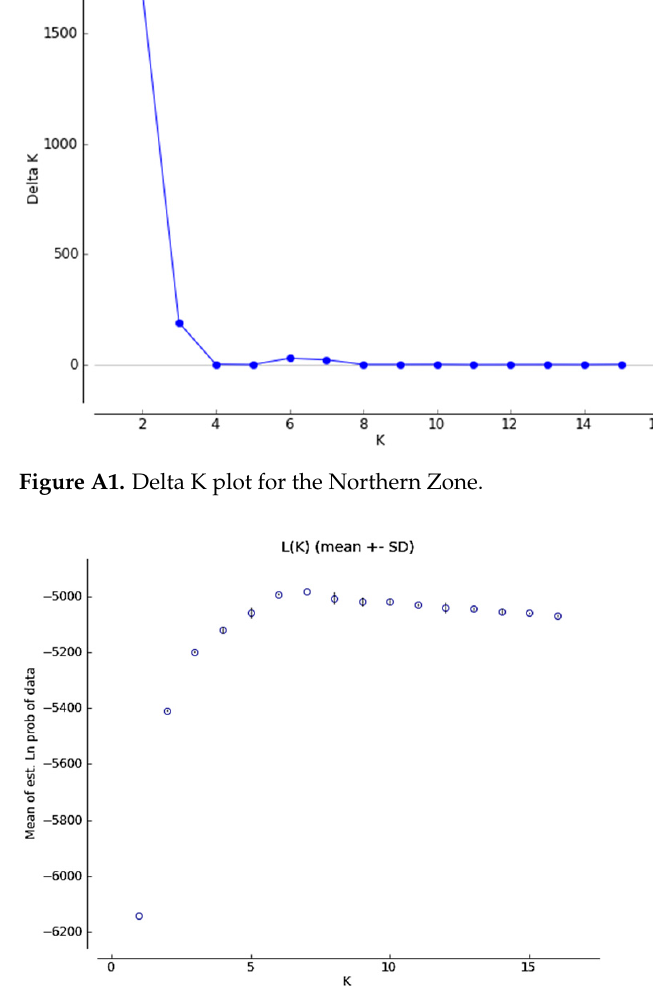
Figure A4. Mean Ln(K) plot for the Southern Zone. References 1.